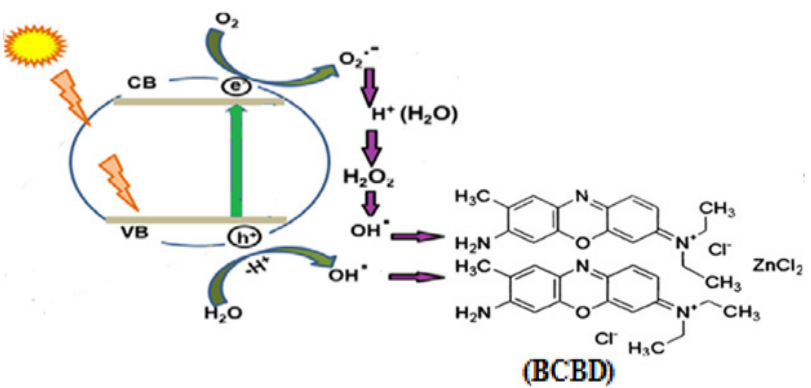
Fig. 11. the schematic view of the BCBD degradation mechanism by using zinc aluminate MSS sample as a